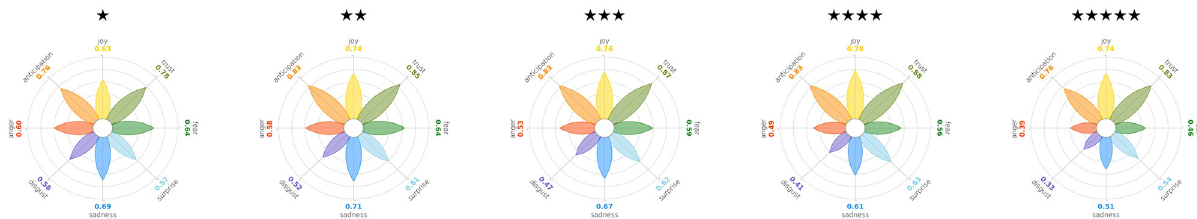
Fig 10. Average emotion scores in a sample of textual reviews of office products on Amazon. Rating of products goes from one star (worst) to five (best). On the left, emotions detected in negative reviews (one star), on the right the emotions detected in positive reviews (five star). While positive emotions stay roughly the same, negative emotions such Anger , Disgust and Fear substantially drop as the ratings get higher.